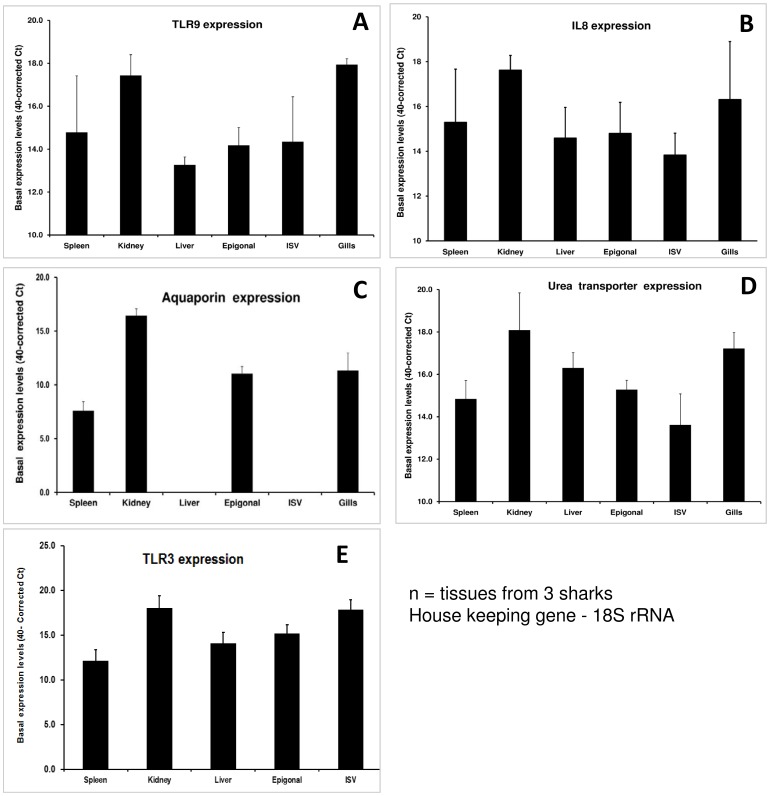
Transcript validation by real-time quantitative PCR.The basal mRNA expression levels of the identified transcripts were determined by designing the primers based on the sequence data generated. The expression levels of the different mRNA in the tissues are indicated 40-corrected Ct values. A. TLR9 mRNA; B. IL8 mRNA; C. Urea transporter mRNA; D. Aquaporin mRNA and E- TLR3 mRNA. Note: The increased levels of TLR9, TLR3 and IL8 in kidney, gills & epigonal confirming their immunological role, while kidney and epigonal expressed higher levels of aquaporin confirming their role in solute balance.